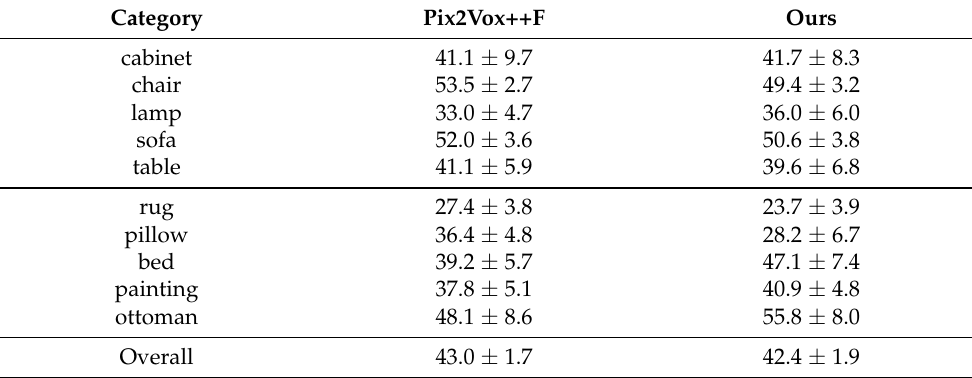
Table 3. Comparison of IoU per category, obtained from 8 views selected from the ABO dataset. We report the mean IoU over all objects per